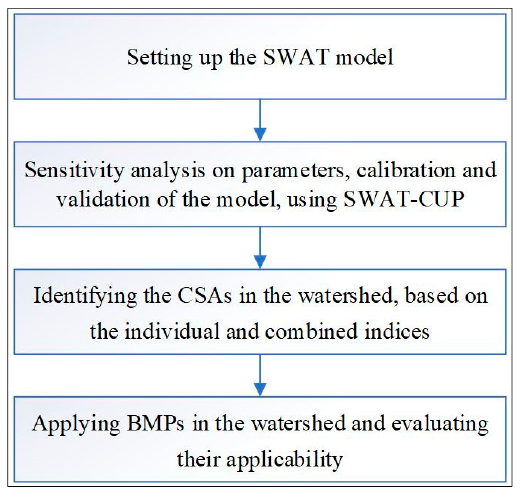
Figure 1. The flowchart of this study.